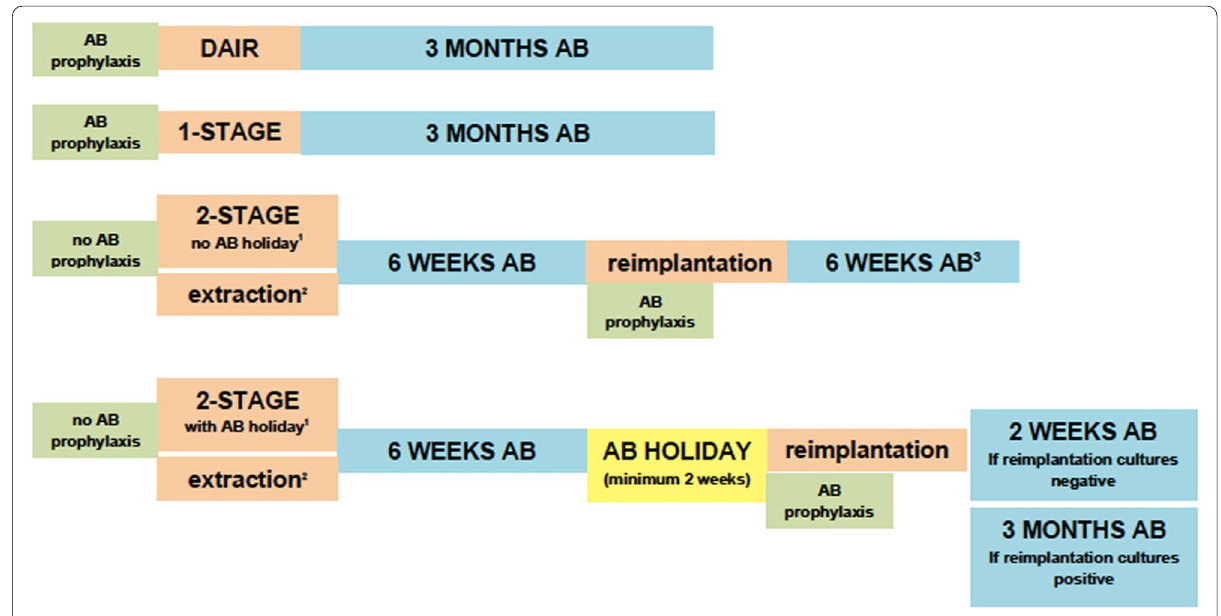
Fig. 3 Surgical strategy in relation to antibiotic treatment